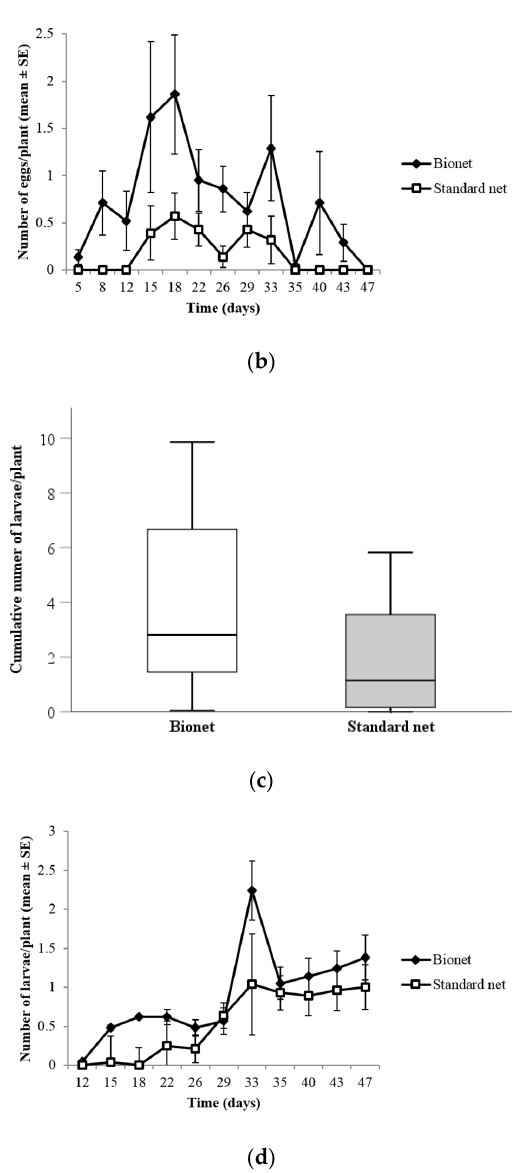
Figure 2. Cumulative abundance and temporal evolution (Mean ± SE) of syrphid immature stages under each type of net: ( a ) Cumulative number of syrphid eggs; ( b ) syrphid egg counts; ( c ) cumulative number of syrphid larvae; ( d ) syrphid larvae